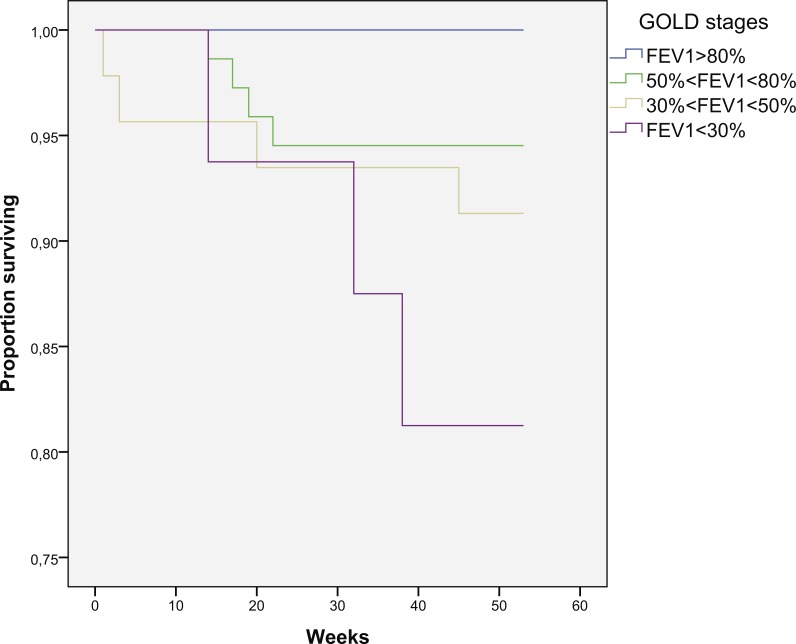
Kaplan–Meier curve for one-year survival depending on GOLD stages (in weeks).